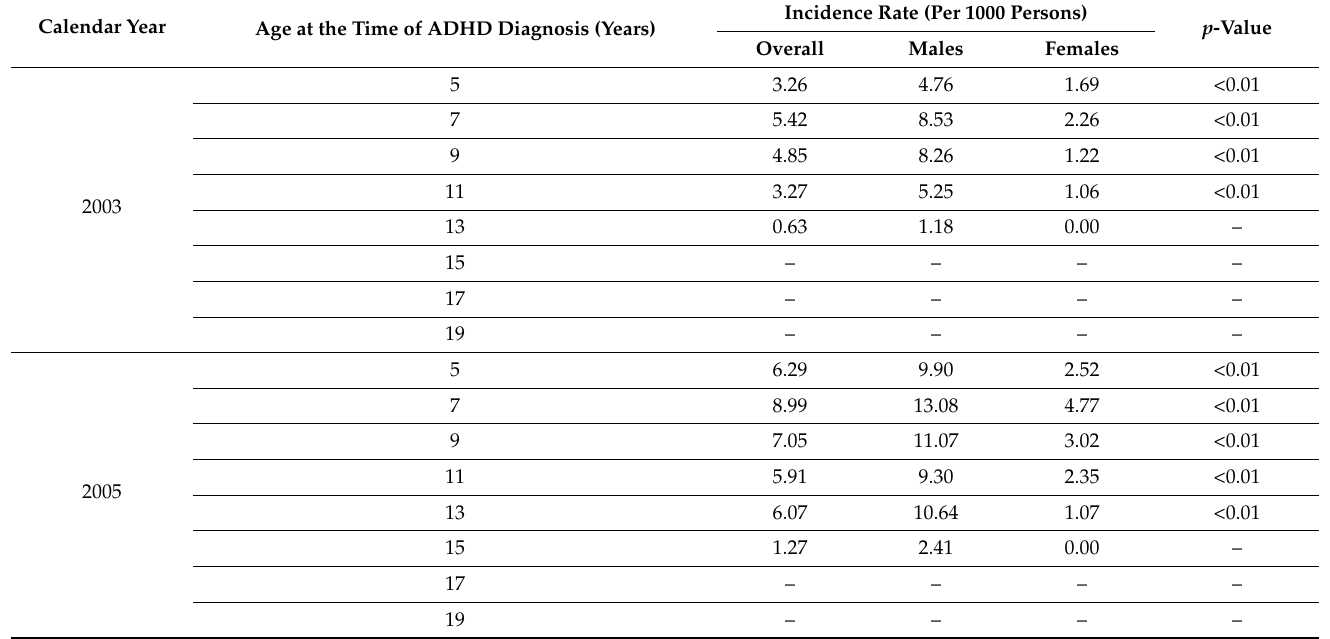
Table 1. Incidence rate of Attention deficit hyperactivity disorder (ADHD) diagnosis according to calendar year, patients’ age at the time of ADHD diagnosis, and